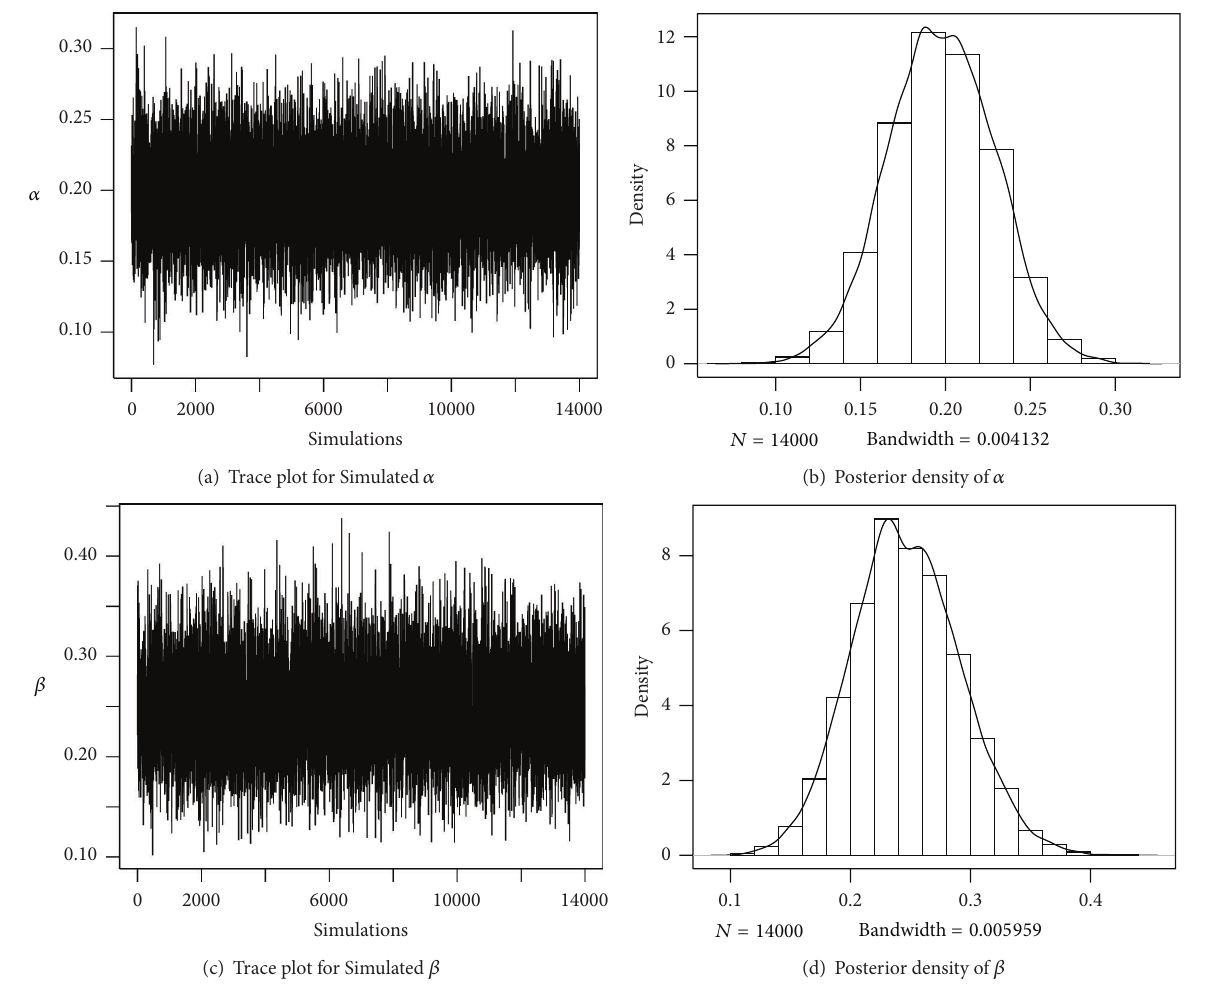
Figure 3: MCMC runs and posterior density plot of 𝛼 and 𝛽 for complete real data